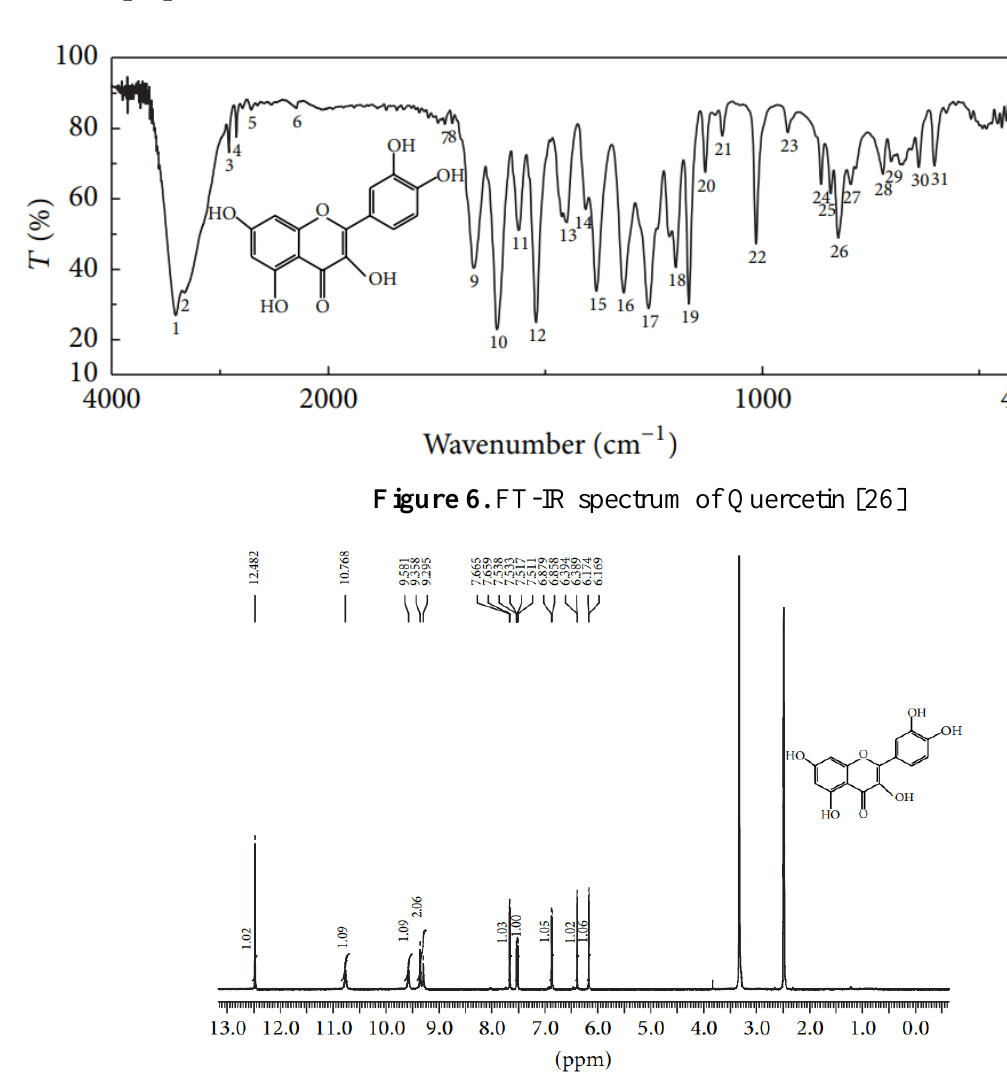
Figure 7. 1 H‐NMR spectrum of Quercetin